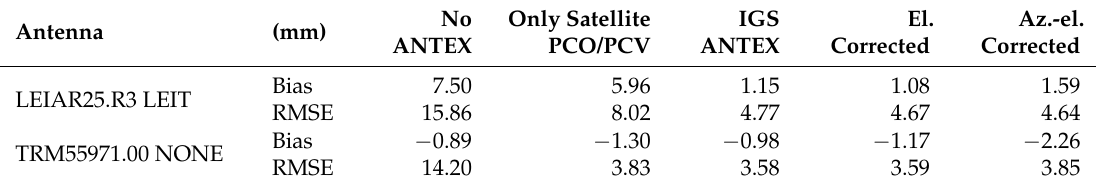
Table 5. ZTD estimation based on antenna PCV corrections with no ANTEX corrections, only satellite